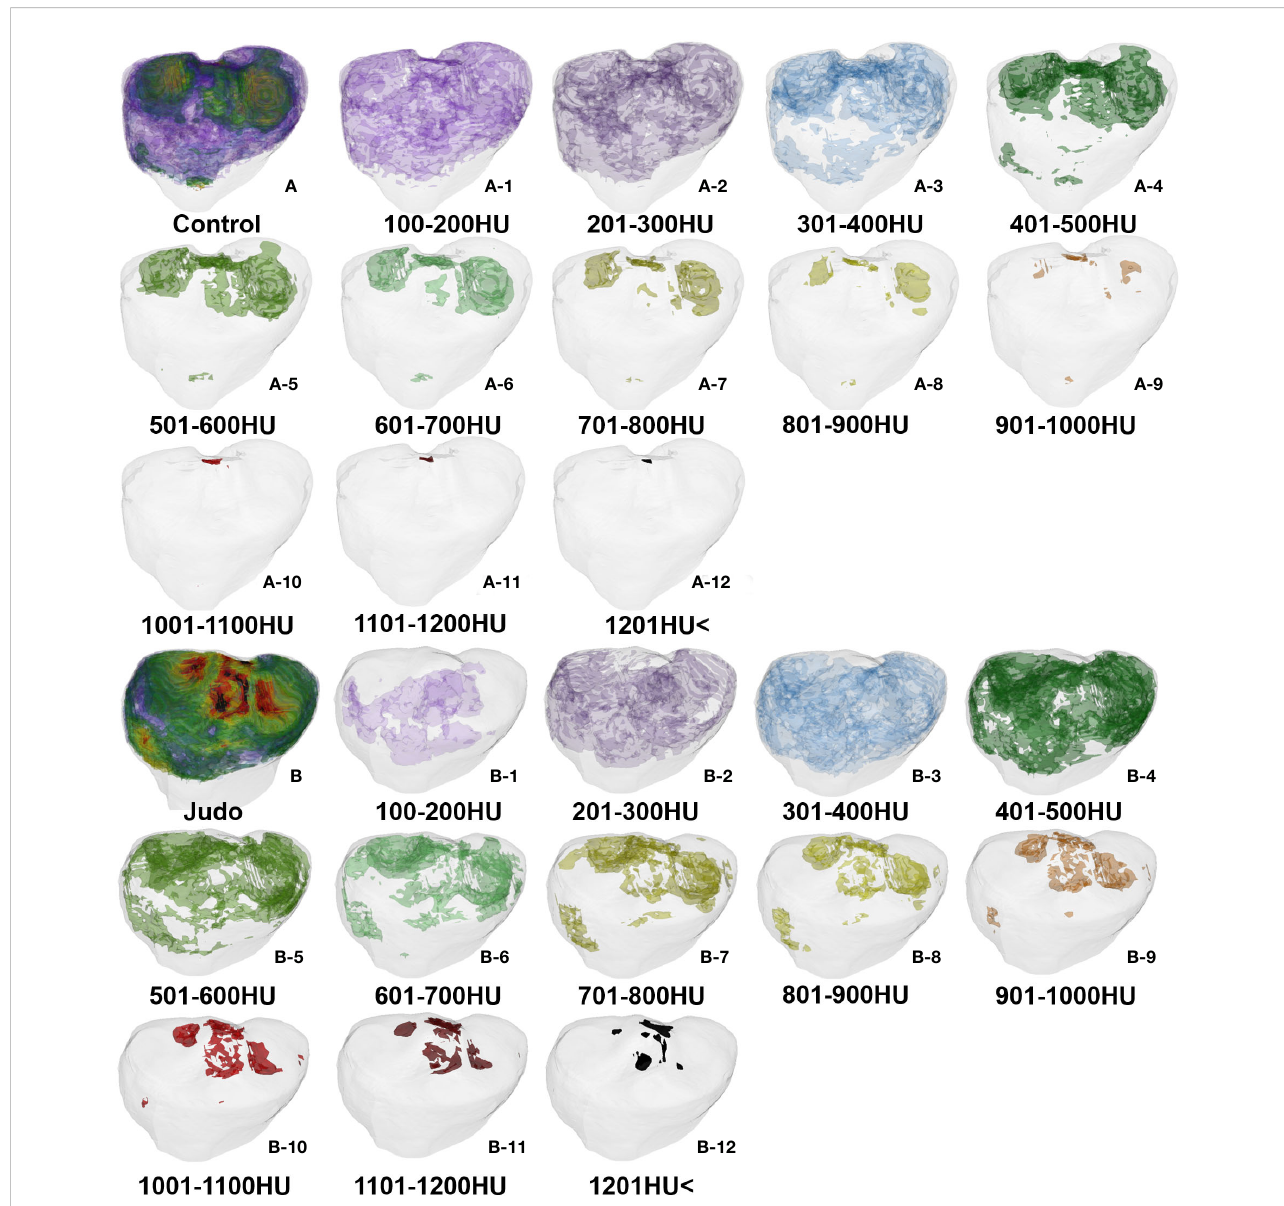
FIGURE 7 Bone tissue volume distribution of bone densities in the tibial plateau: (A) Control group (A-1 – A-12) and (B) Judo group (B-1 – B-12)